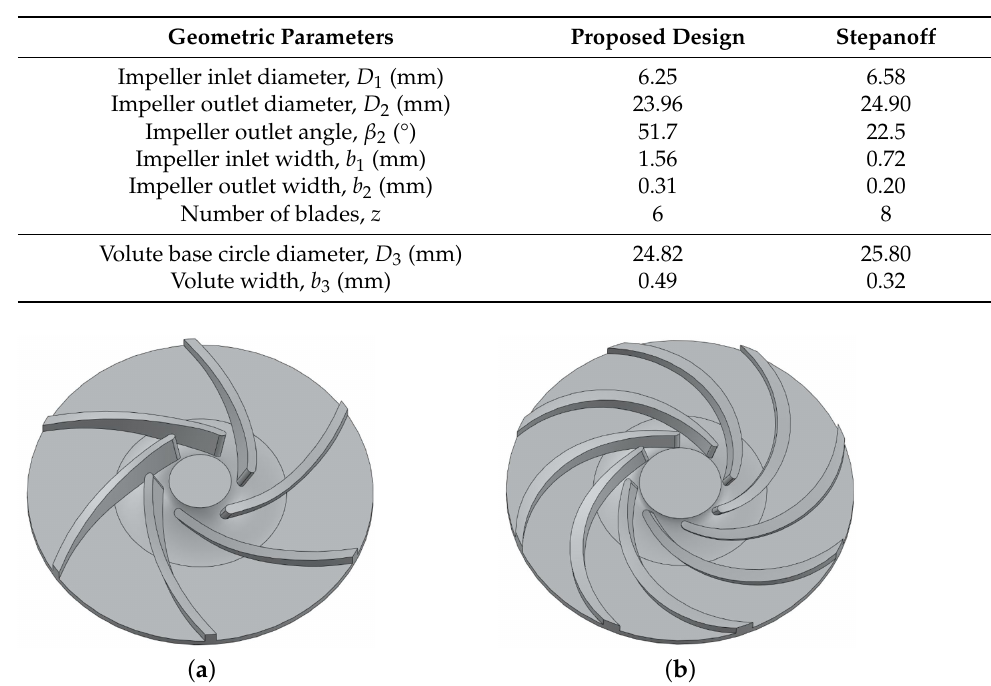
Table 4. Design parameters of the pump using the proposed method and Stepanoff method.